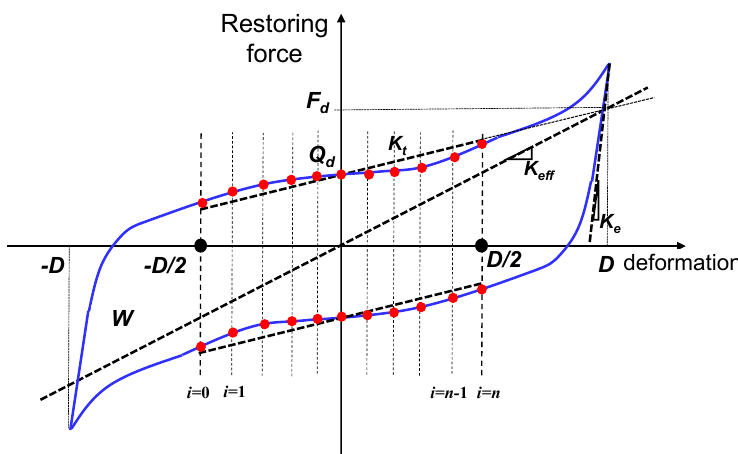
Figure 12. Illustration of the proposed method for determination of tangential stiffness and effective stiffness.